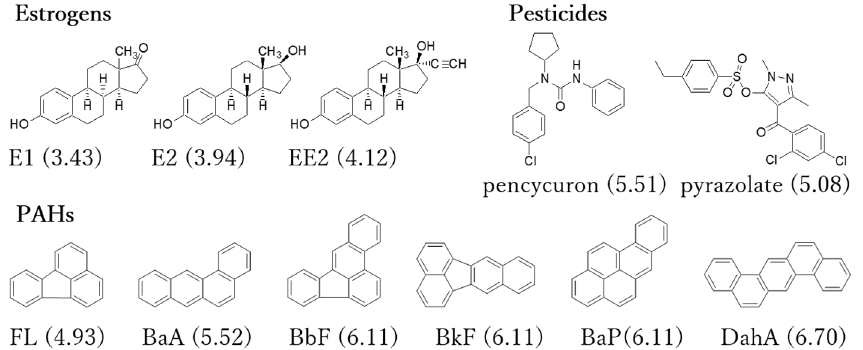
Figure 5. Chemical structure of environmental pollutants studied. The numbers in parentheses are the log K owwin of the pollutant [27]. E1: estrone, E2: 17 β -estradiol, EE2: ethinylestradiol, PAHs: polycyclic aromatic hydrocarbons, FL: fluoranthene, BaA: benzo[a]anthracene, BbF: benzo[b]fluoranthene, BkF: benzo[k]fluoranthene, BaP: benzo[a]pyrene, and DahA: dibenzo[ah]anthracene.